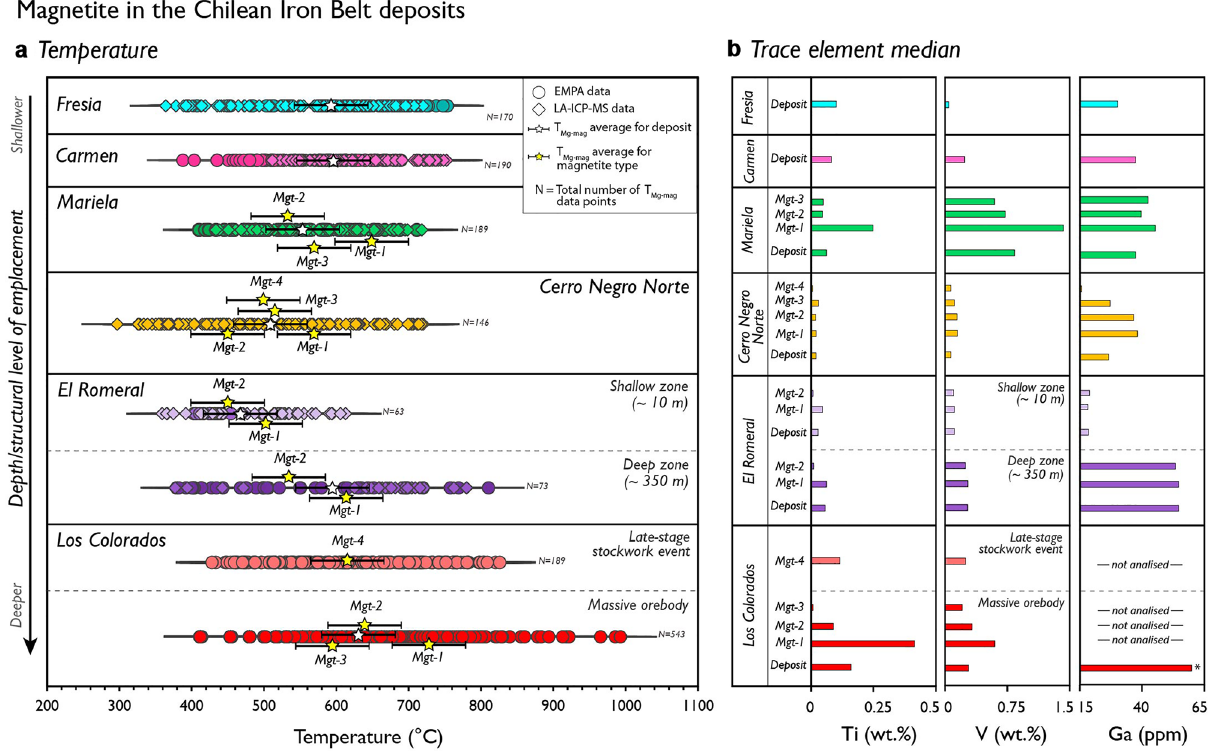
Figure 2. Calculated temperatures and median concentrations of selected trace elements in magnetite from IOA deposits of the Chilean Iron Belt. (a) Temperatures calculated using the T Mg-mag thermometer 43 . Uncertainties (error bars) are at ± 50 °C. (b) Titanium, V and Ga median concentrations determined by LA-ICP-MS, except for Los Colorados in which EMPA (Ti, V) and LA-ICP-MS (Ga) data were